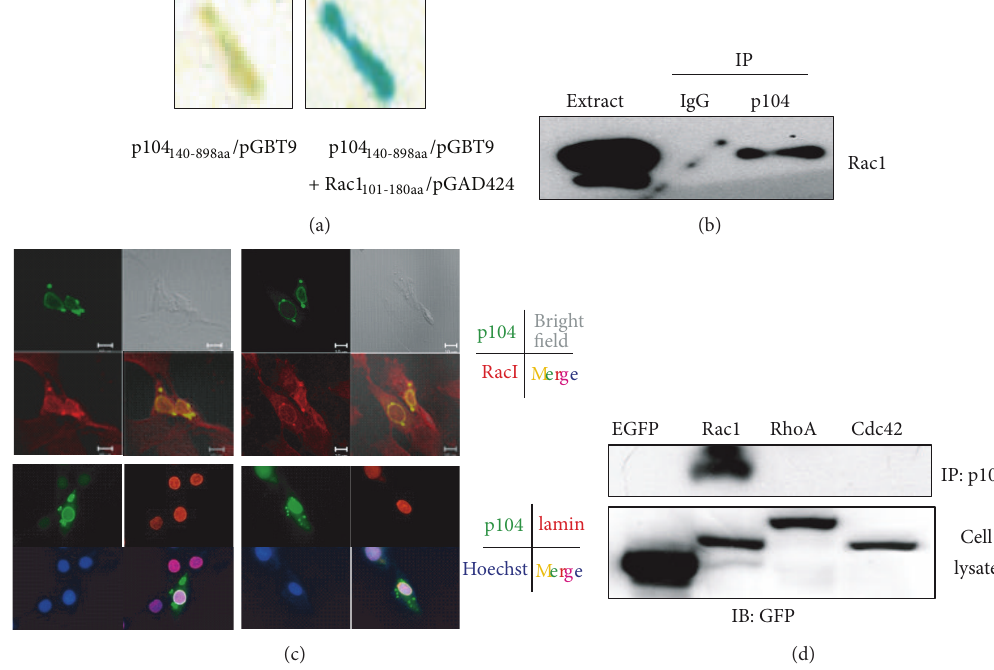
Figure 1: Rac1 was isolated as a binding protein of p104. (a) The DNA-encoding p104 (amino acids residue 140–898) was inserted into the Eco RI/ Pst Isite of a GAL4 DNA-binding domain vector pGBT9. After colony selection on plates lacking Trp, His, and Leu, 𝛽 -galactosidase assay was performed on the filter. Rac1 clones were isolated as a binding partner of p104. (b) Using anti-p104 serum, immunoprecipitation was performed with mouse brain extract and analyzed by Western blotting with an anti-Rac1 antibody. Immunoprecipitation using an unrelated antibody (IgG) was used as a negative control. (c) Colocalization of p104 and Rac1 in NIH3T3 cells. NIH3T3 cells were grown on cover slips in 6 well plates and transfected with the pEGFP C1-p104 plasmid. After 24 h, cells were fixed and stained with a Rac1 or lamin antibody followed by a Rhodamine-conjugated anti-rabbit antibody. Fluorescence was observed using a confocal microscope (upper eight panels) or fluorescence microscope (lower eight panels). (d) p104 was specifically associated with Rac1. The carboxy-terminal domain of Rac1, RhoA and Cdc42 was fused with EGFP and transfected into C2C12 cells. After 24 h, cell lysates were immunoprecipitated with anti-p104 serum and Western blot analysis was performed using an anti-GFP antibody. The expression of EGFP-fused Rac1, RhoA, and Cdc42 is shown as a control in the lower